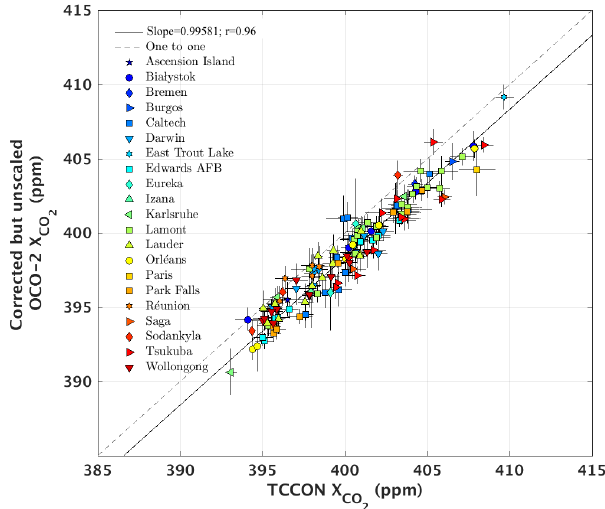
Figure 16. Scatter plot of 130 OCO-2 B8 target-mode X CO vations versus colocated TCCON observations, used in the determi- nation of the global scaling factor C 0 from Eq. (6). OCO-2 values have the parametric and footprint bias corrections